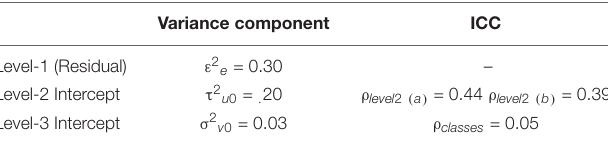
TABLE 9 | Random effects variance components and ICC values for the multilevel model without predictors (empty model) for the population